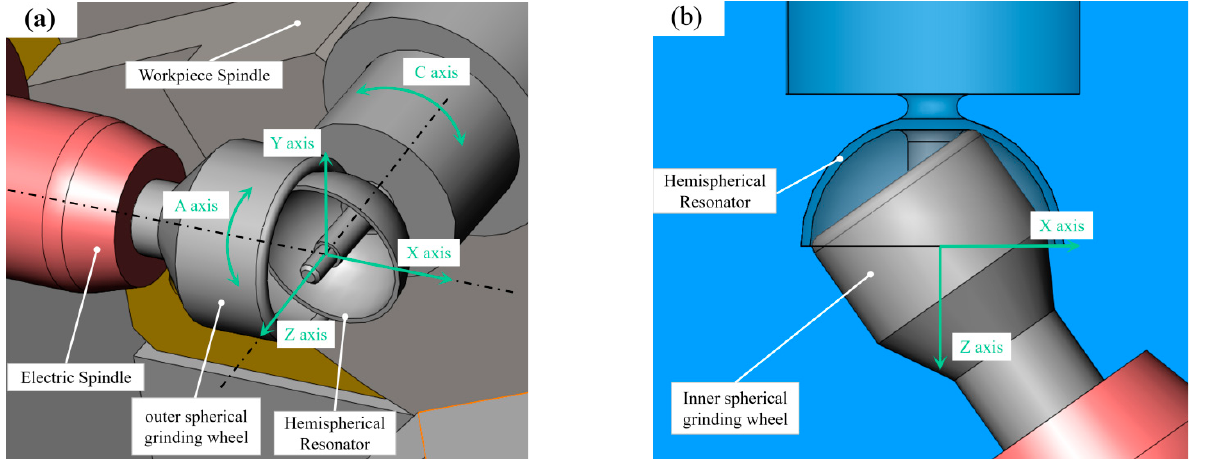
Figure 2. Tool-workpiece junction geometric model of HSR grinding: ( a ) external spherical grinding, ( b ) internal spherical grinding.